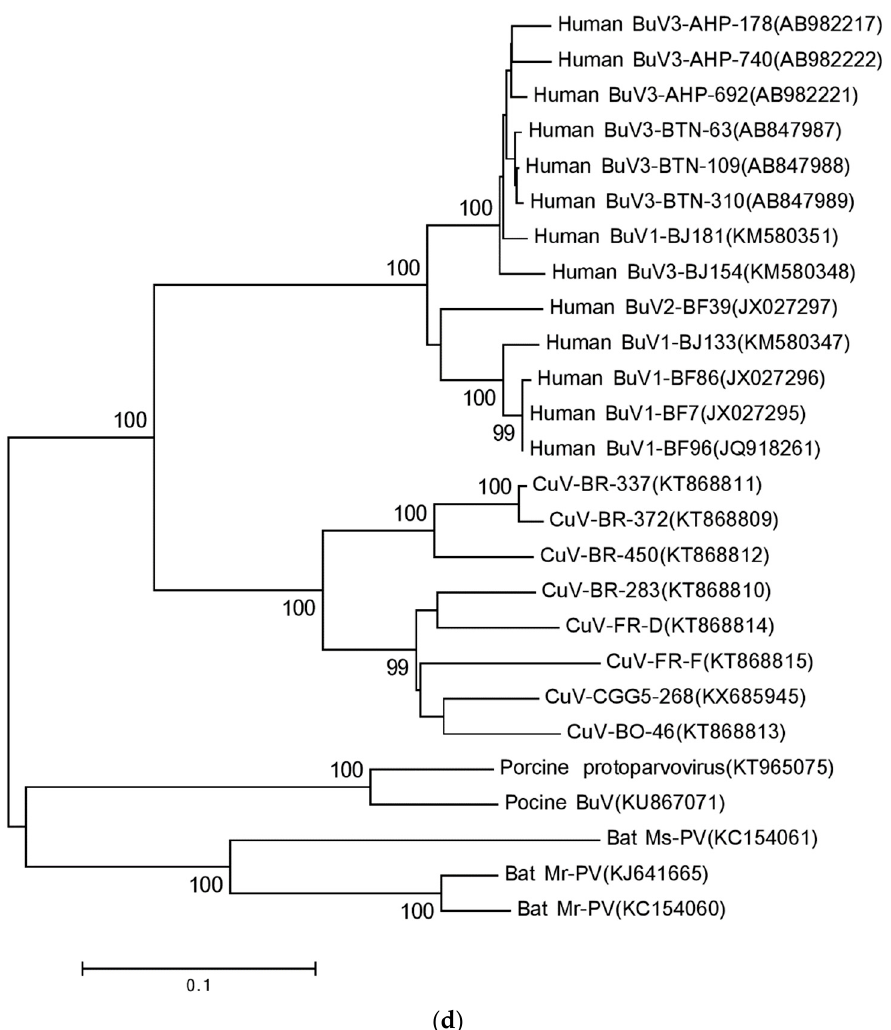
Figure 1. Schematic illustration of genomic structures and phylogenetic analyses of the sequences of BuVs, CuVs, TuV, and other members of Protoparvovirus . ( a ) Schematic illustration of BuV, TuV, CuV, and MVMp genomic structures. The hairpin regions are unknown for BuV, TuV, and CuV, and the hairpins of MVMp are represented as straight lines for this simplified scheme. Species, strain, GenBank no., and the length of genome are indicated; Phylogenetic analyses of ( b ) NS1 sequences; ( c ) VP2 sequences; ( d ) short middle ORF sequences (not available from TuV). The phylogenetic analysis was based on nucleic acid sequences. Sequences were aligned with ClustalX (Version 2.1) [14] using a protospacer adjacent motif (PAM) with a gap open penalty of 10 and gap extension penalty of 0.1. The neighbor-joining phylogenetic tree was generated with bootstrap values determined by 1000 replicates in the Molecular Evolutionary Genetics Analysis (MEGA)(Version 7.0) [15]. The evolutionary distances were calculated by the p-distance method. Bootstrap values are shown if >80%. NS1, non-structural protein 1; mORF, short middle ORF; VP1, viral capsid protein 1; VP2, viral capsid protein 2; NS2, non-structural protein 2.